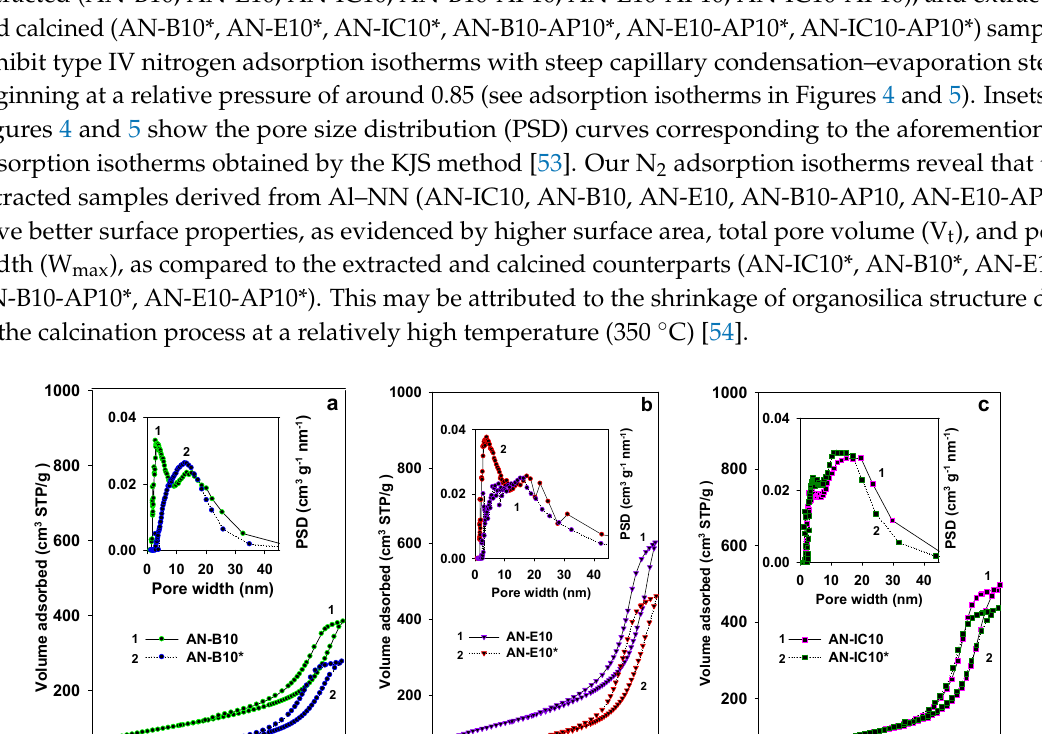
B10 (left panel a ), AN-E10 (middle panel b ), and AN-IC10 (right panel c )), and extracted and calcined (AN-